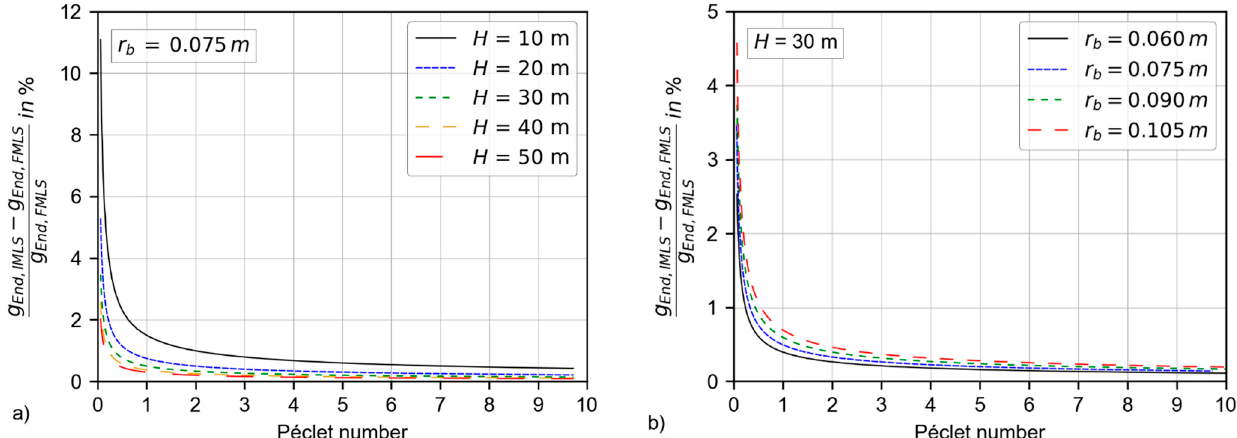
Figure 3. Percentage deviation of the g-functions calculated with the infinite and finite MLS with an isothermal boundary condition at the ground surface ( a ) for a borehole radius of rb = 0.075 m and ( b ) a borehole length of H = 30 m.